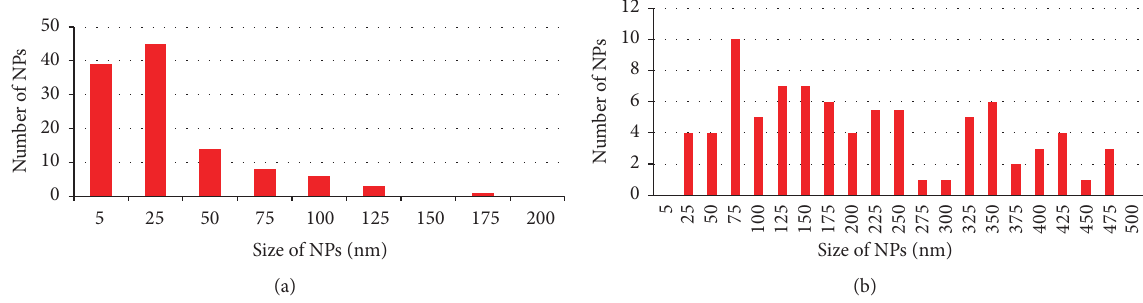
Figure 6: TEM histogram for (a) silver nanoparticles prepared by energy of 700 mJ and 10ns pulse duration and (b) silicon nanoparticles prepared by energy of 700 mJ and 10ns pulse